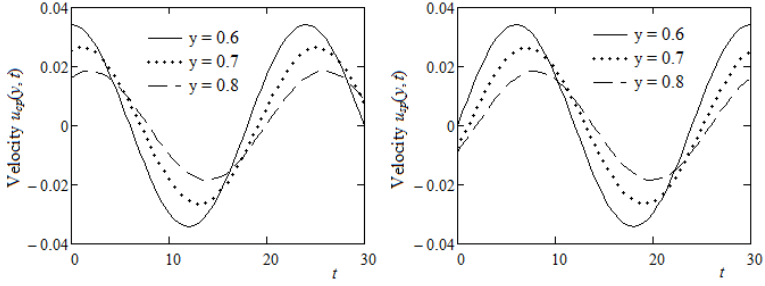
Figure 7. Time variations of the velocity fields u cp ( y , t ) and u sp ( y , t ) for Re = 100, We = 1, ω = π /12, α = 0.8 and increasing values of y .